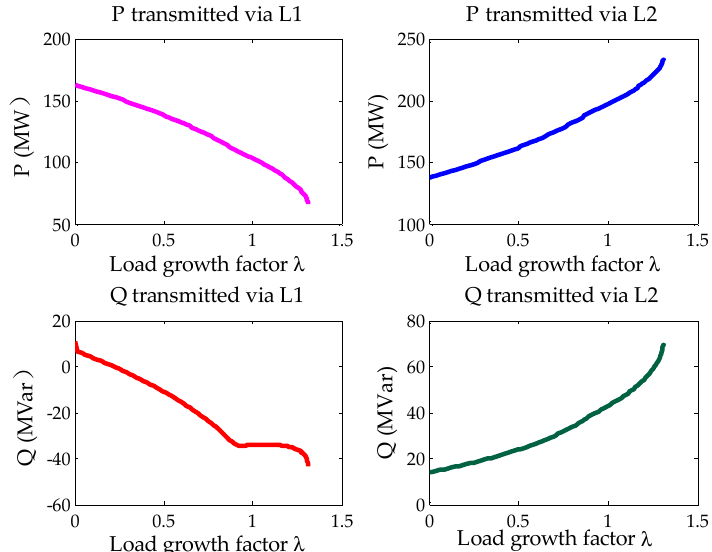
Figure 5. Curves of transmission power in AC tie-lines under scheme M1.